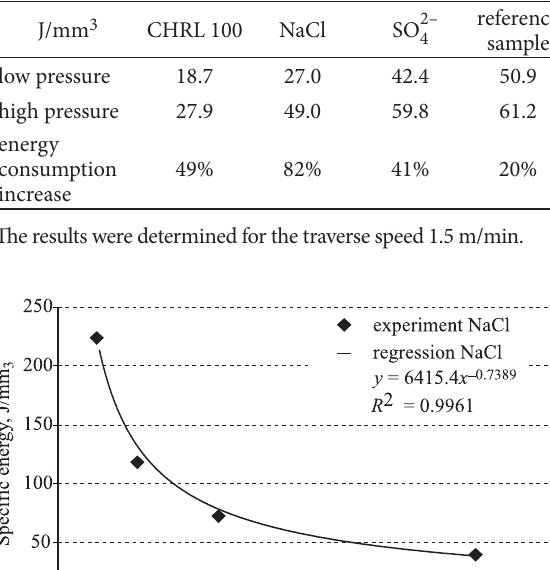
Table 3. Comparison of water jets generated by low and high pressure from the energy consumption point of